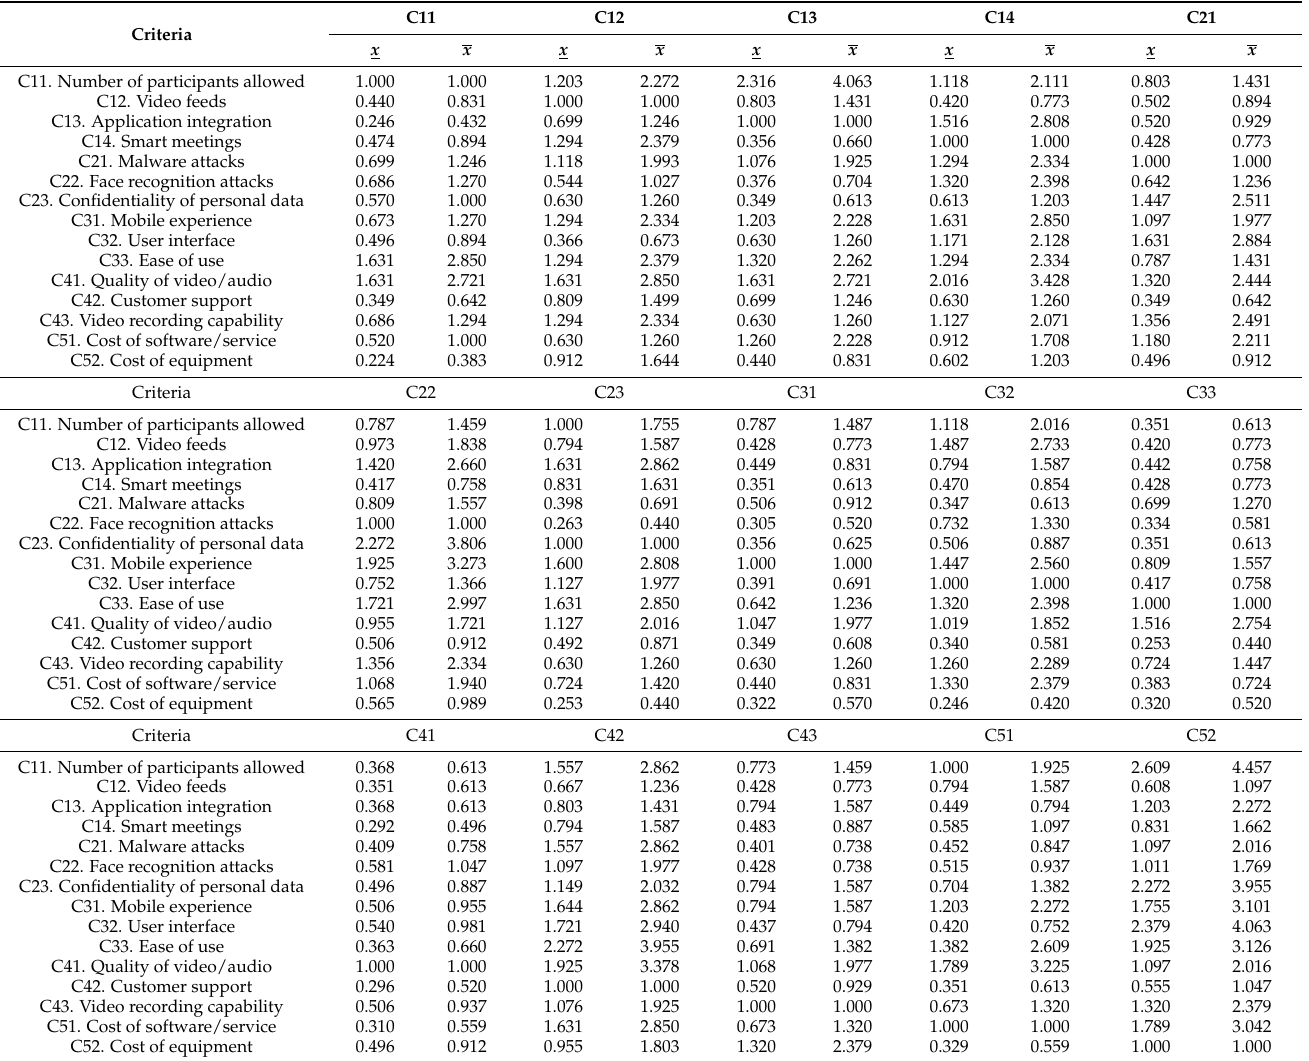
Table A1. The integrated grey comparison matrix of